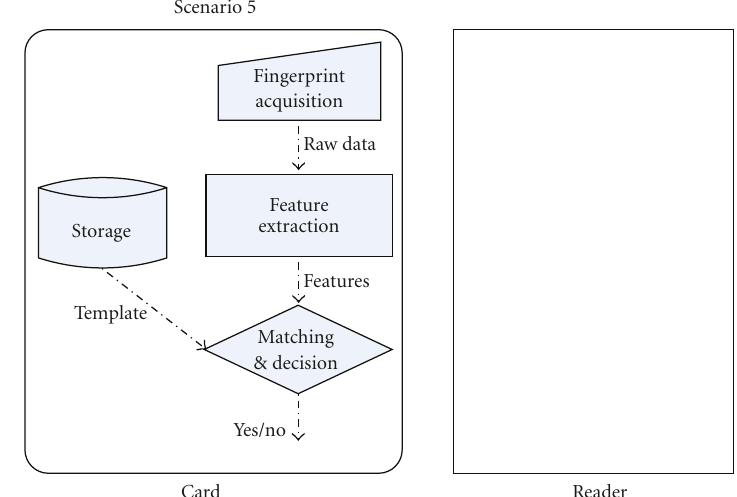
Figure 3: Illustration of the integrating scenarios [23–26] for system-on-card and the corresponding X9.84 [27]